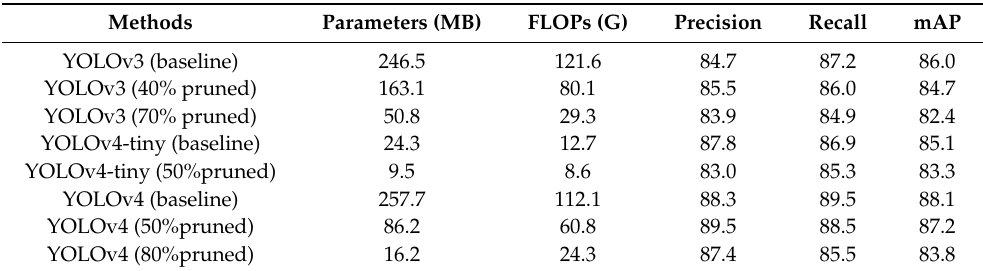
Table 3. Performance evaluation on the RSOD